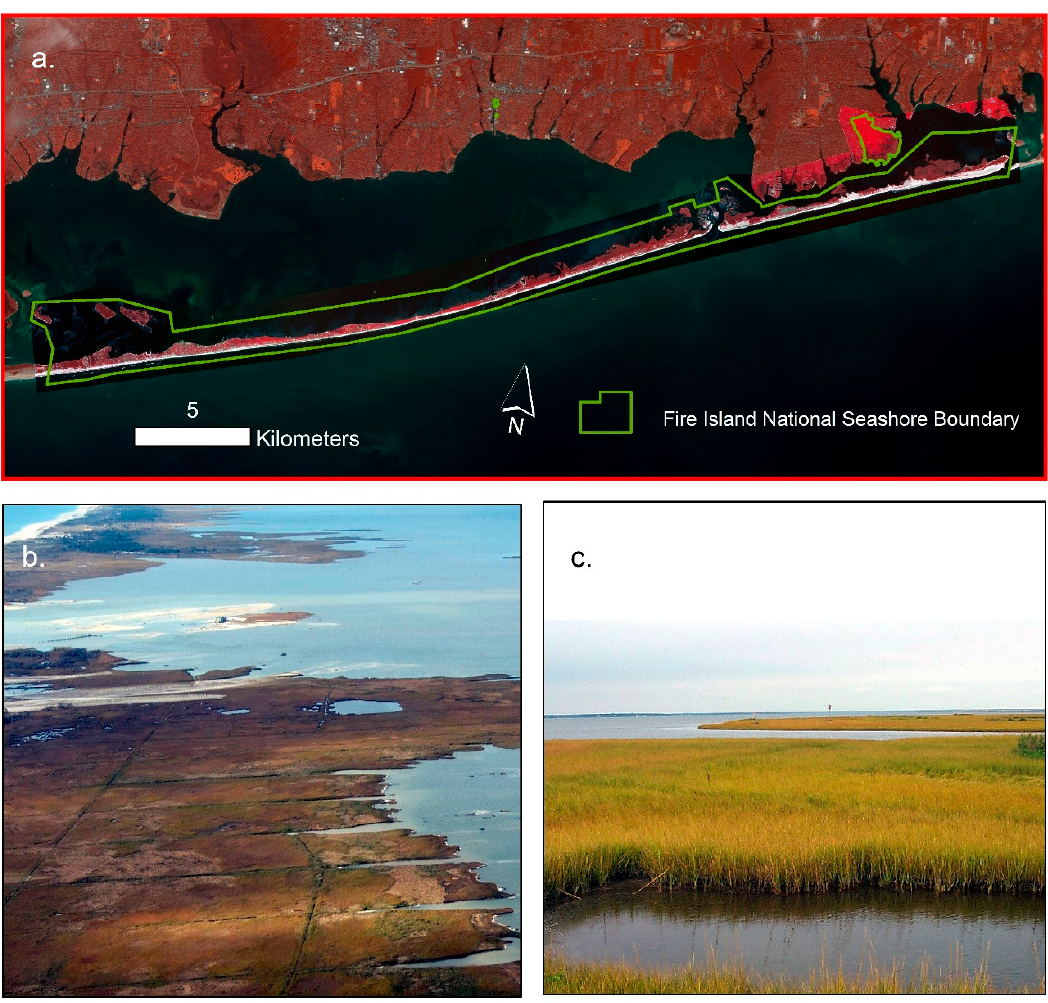
Figure 1. ( a ) A mosaic of Worldview-2 and Worldview 3 imagery of Fire Island and Sentinel-2 satellite image of the surrounding area (NIR, G, B displayed as R, G, B). ( b ) A post-Hurricane Sandy oblique aerial view acquired by U.S. Geological Survey (USGS) showing the bayside salt marshes surrounding the breach [44]. ( c ) A field photo of the Fire Island National Seashore (FIIS) salt marsh landscape.